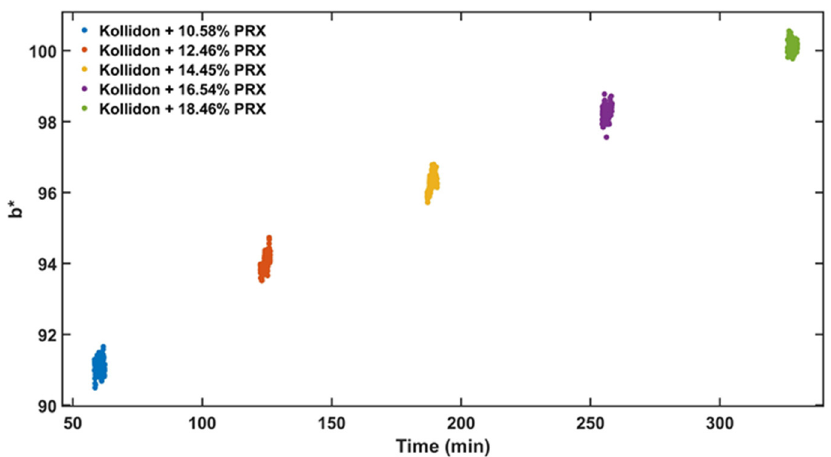
Figure 5. b* (blue to yellow colour parameter) vs. experiment time of the calibration data set.